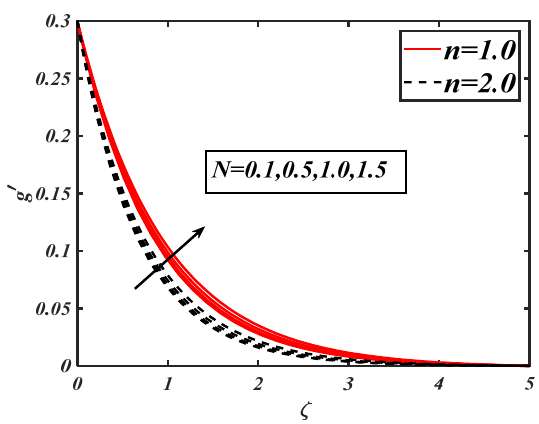
′ ′ . Figure 9. N illustration against g (cid:48) . .